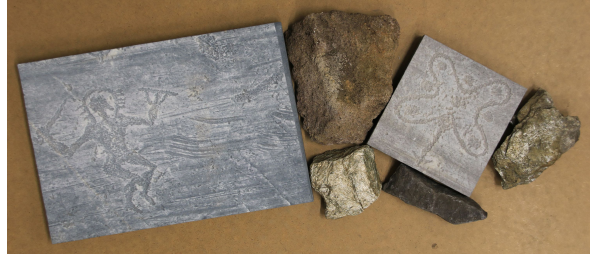
Figure 9: Test scene I as used for measurements of a compact scene: Two 3D prints of Valcamonica rock-art and some rock samples are arranged to comprise a scene of roughly 90 cm by 30 cm.